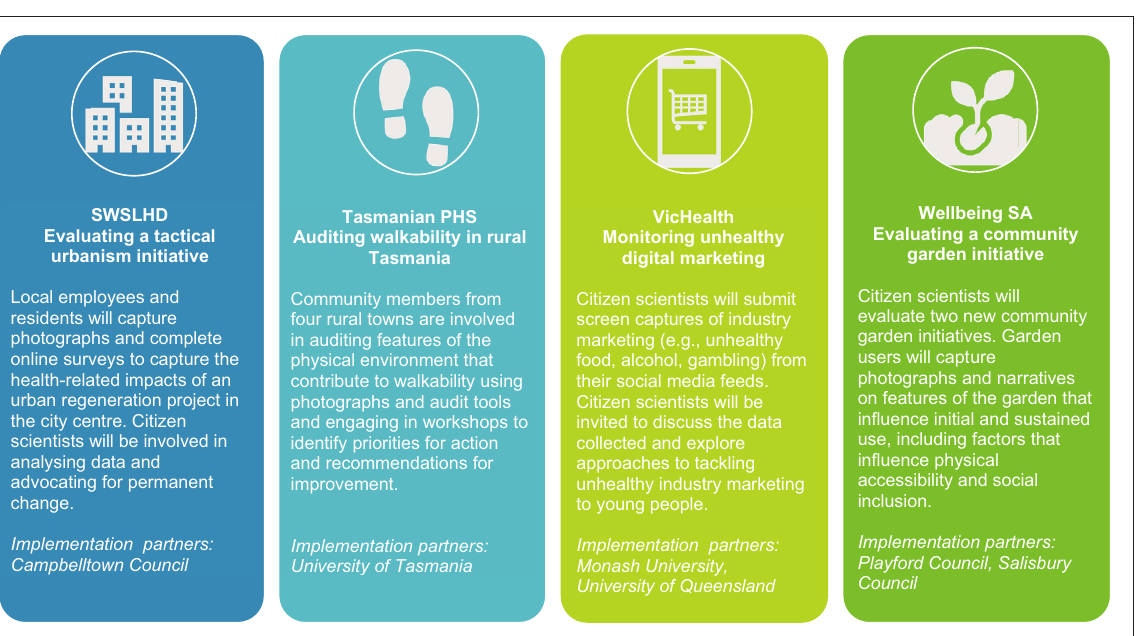
Figure 1 Overview of the four citizen science projects included in the